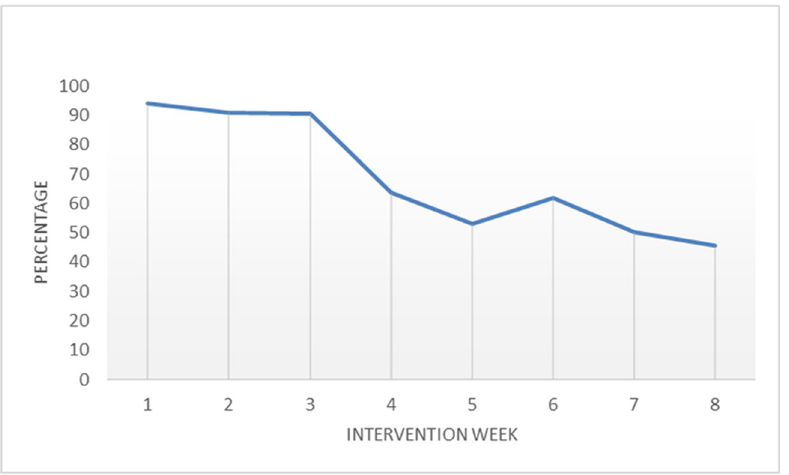
Fig 2. Participants’ adherence to prescribed walking